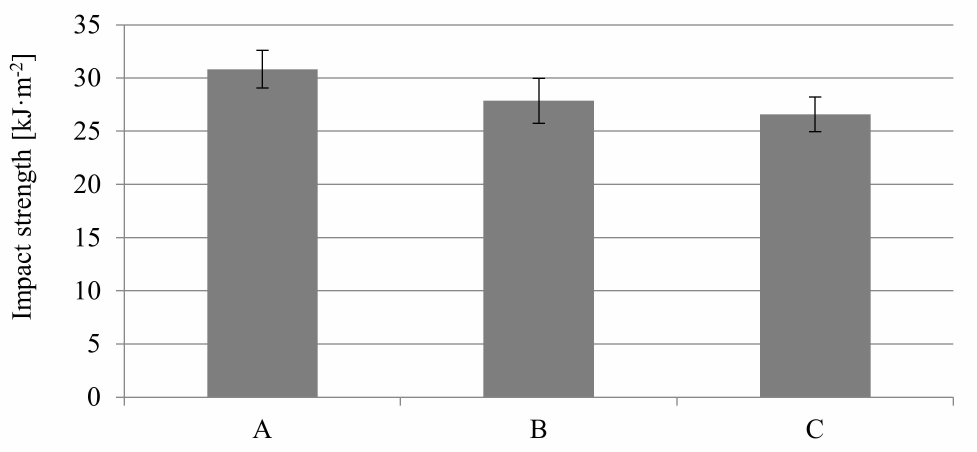
Figure 18. Influence of nitrogen pressure on the impact strength for notched PA66 GF30 moldings with a thickness of 8.4 mm, where A is a solid sample, while B and C are foamed at 16 and 20 MPa nitrogen pressure